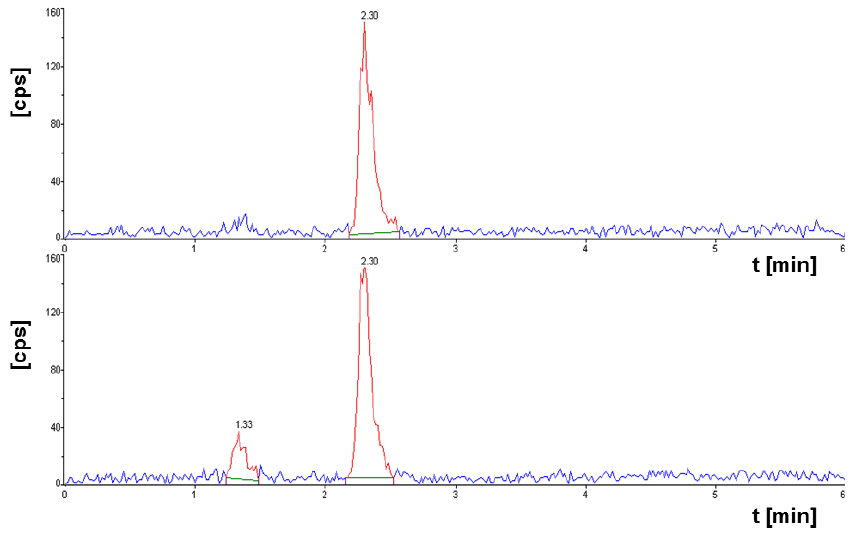
Figure S2. [ 177 Lu] NT127 after incubation in human serum in vitro at 37 °C for 15 min ( upper HPLC chromatogram ), and for 3.5 h ( lower HPLC chromatogram ).